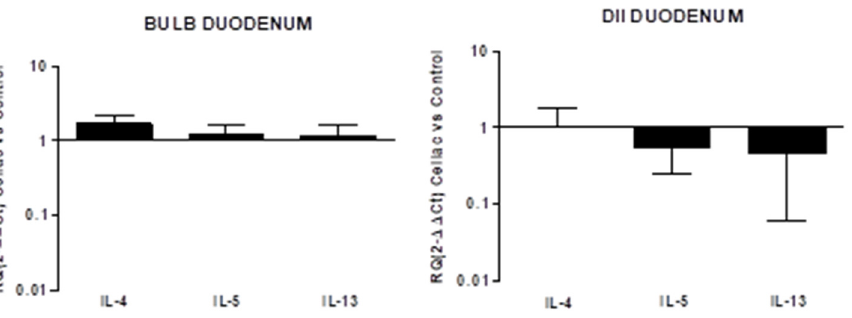
Figure 3. Relative expression of mRNA encoding for IL-4, IL-5 and IL-13 in mucosal tissue from DII and bulb duodenum. Data are determined by qPCR (log 10 2 − ∆∆ CT vs control). Data are expressed as mean ± SE of 4 experiments.